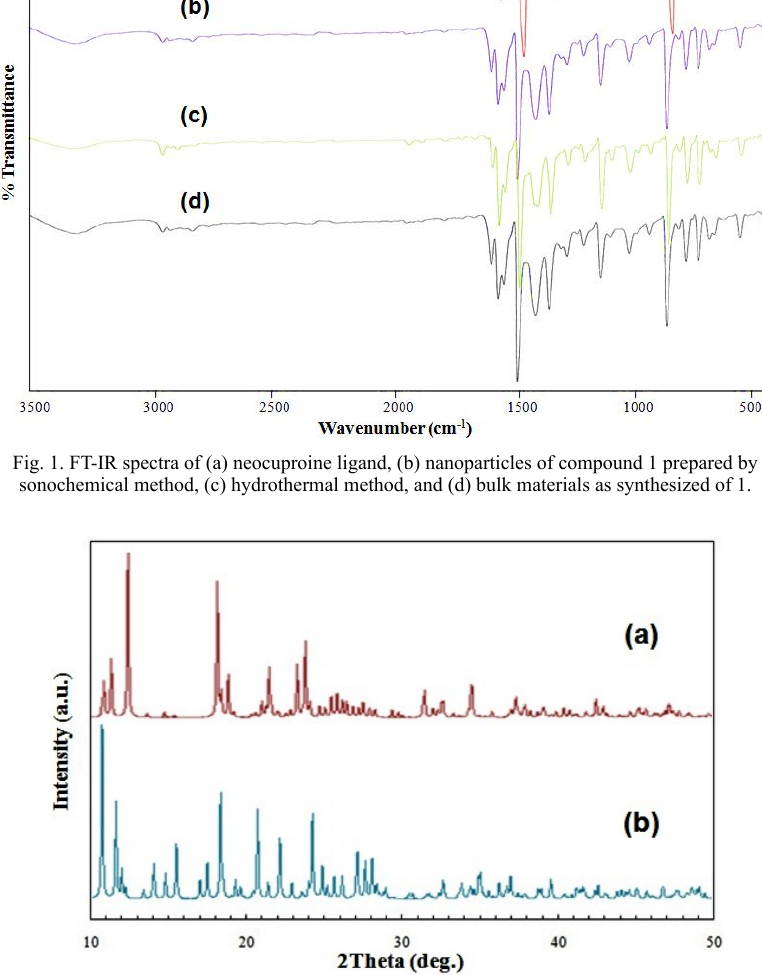
Fig. 2. XRD patterns; (a) simulated pattern based on single crystal data of compound 1, and (b) nanoparticles of compound 1 prepared by sonochemical